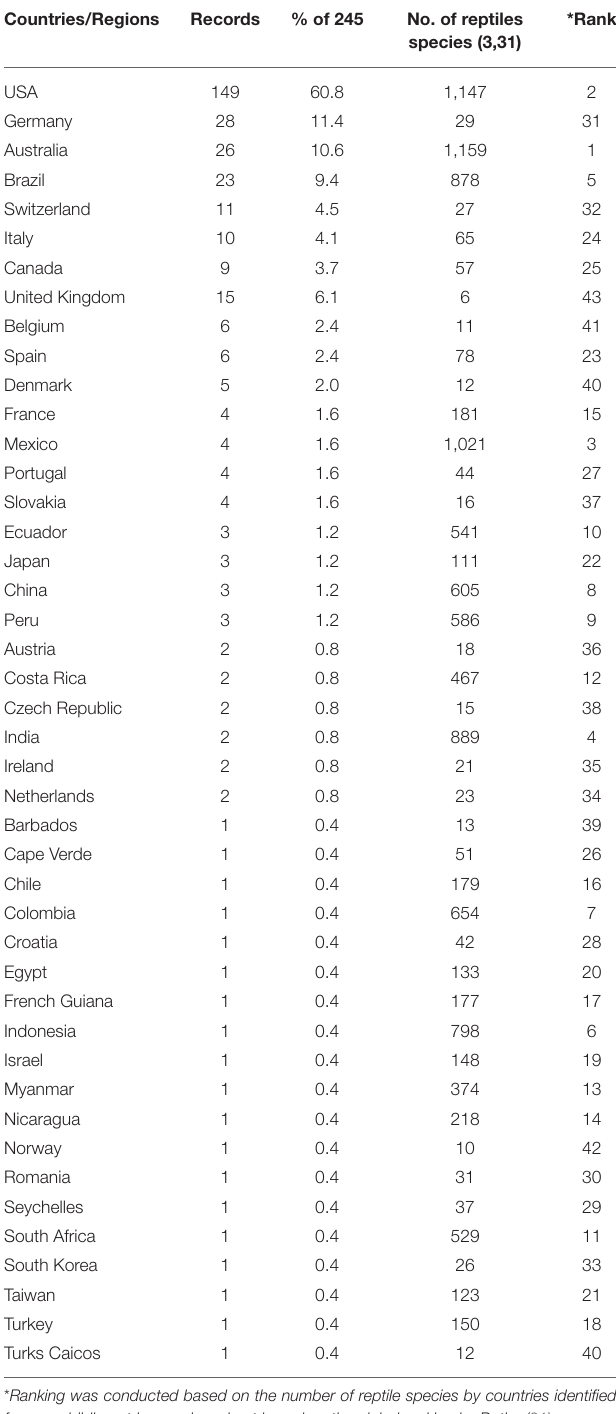
TABLE 1 | Bibliographic data on reptilian herpesviruses based on the number of articles from different countries.